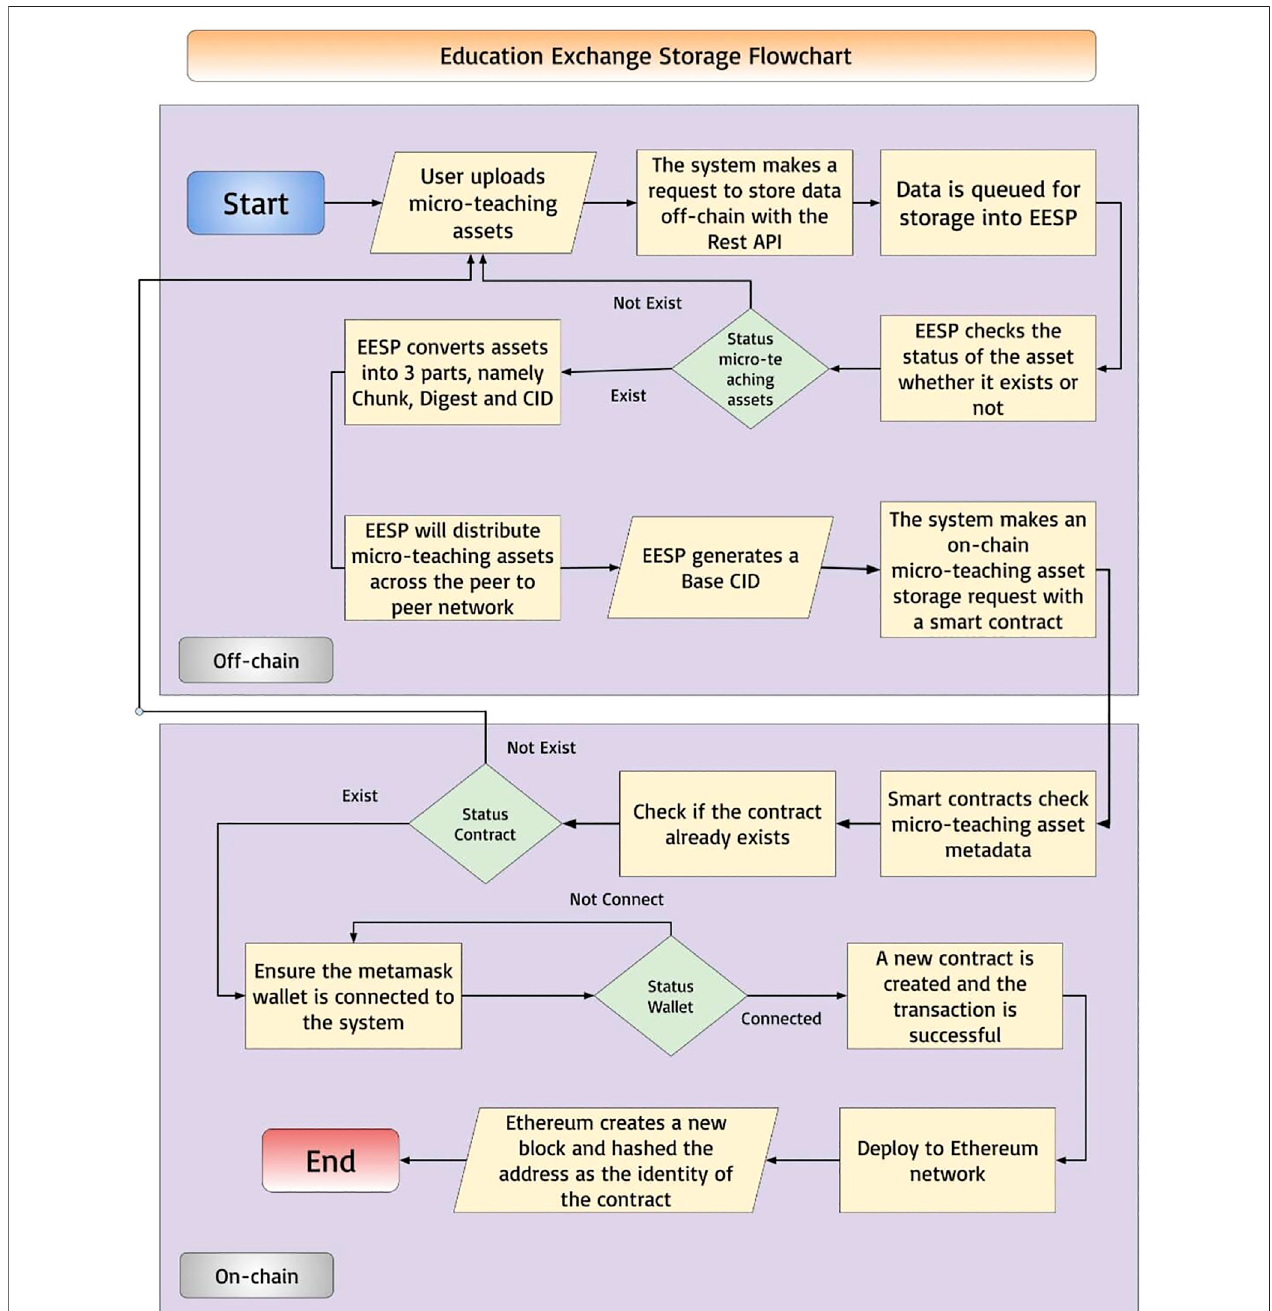
FIGURE 5 | EESP framework part